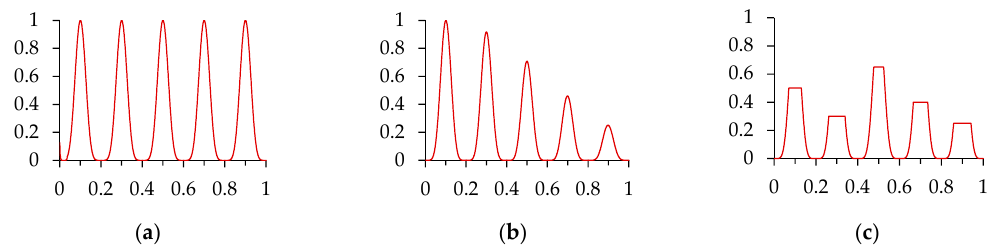
Figure 1. Examples of multimodal maximization functions, including a couple of usual benchmarks: ( a ) Equal Maxima; ( b ) Uneven Decreasing Maxima. The last graph illustrates: ( c ) a case with plateaus.